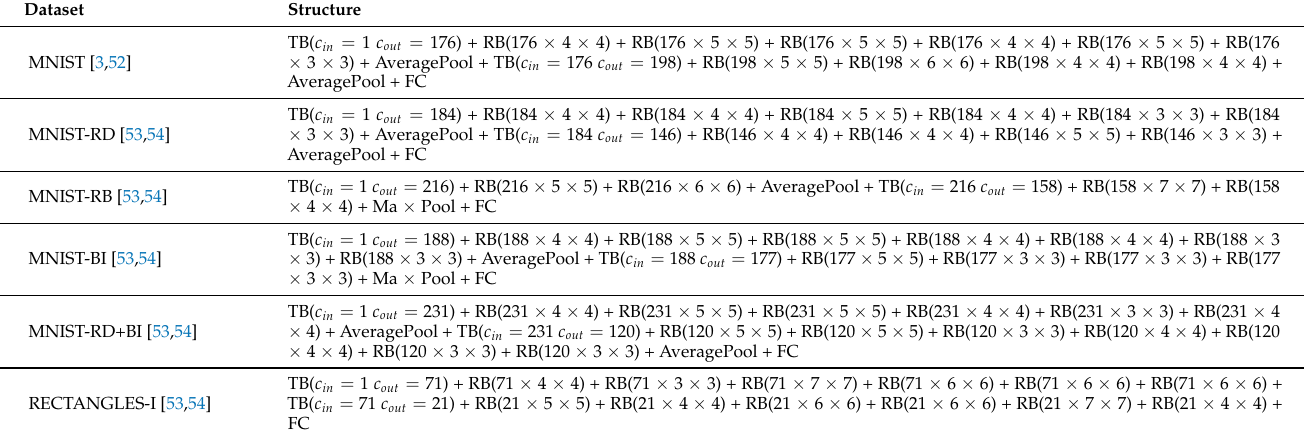
Table 9. The identified best models for all benchmark datasets using resPsoCnn. TB indicates a transitional block which contains a single 1 × 1 convolutional layer and RB indicates a ResNet block which contains two convolutions, as indicated in Figure 3. FC indicates a fully connected